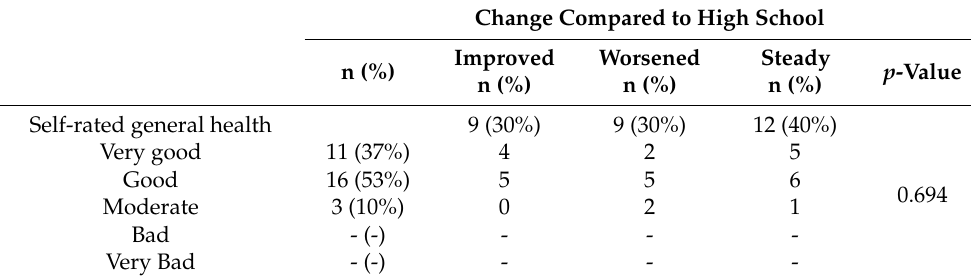
Table 1. Current health status of medical students and change in health status compared with their last year in high school based on the